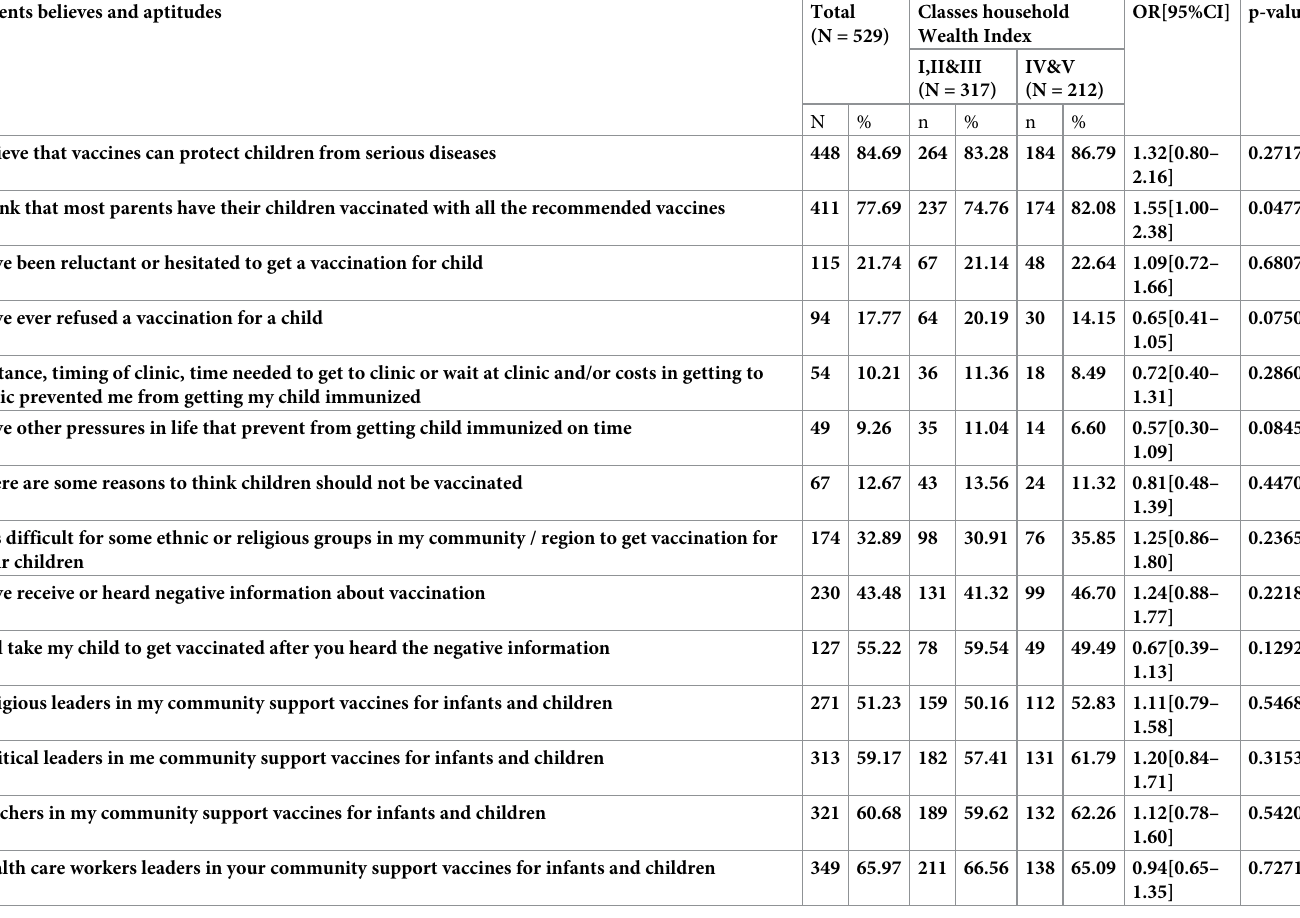
Table 1. Self-reported vaccine hesitancy and parents beliefs on childhood vaccines with respect to the various household wealth levels. Parents believes and